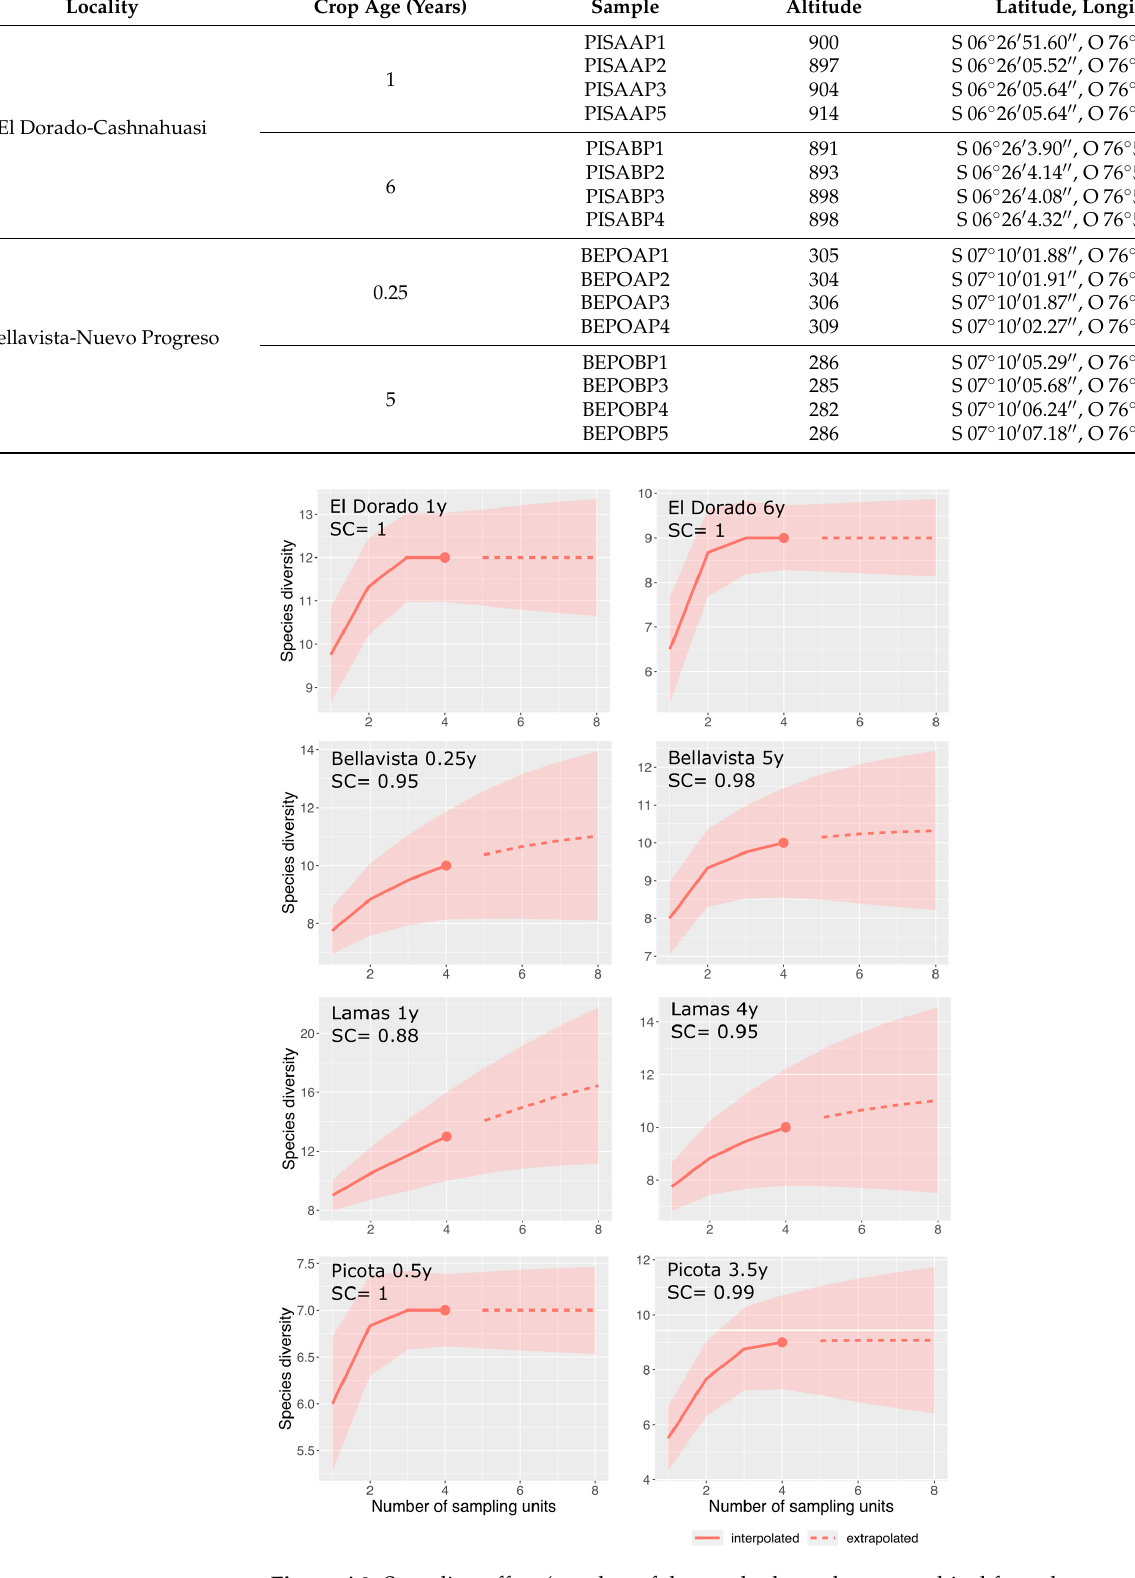
Figure A3. Sampling effort (number of detected arbuscular mycorrhizal fungal taxa per number of analyzed samples) calculated for each site and age using iNEXT R package considering incidence frequency counts. SC–Species coverage from 0 to 1.